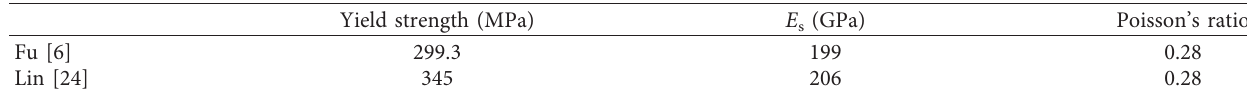
Table 4: Material parameters of steel